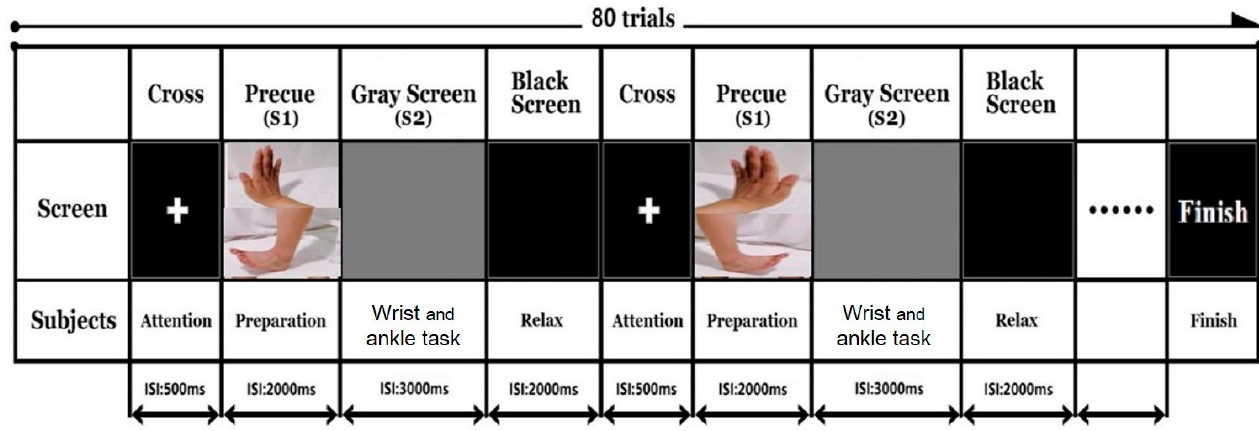
Figure 2. Event related potential paradigm to measure contingent negative variation.